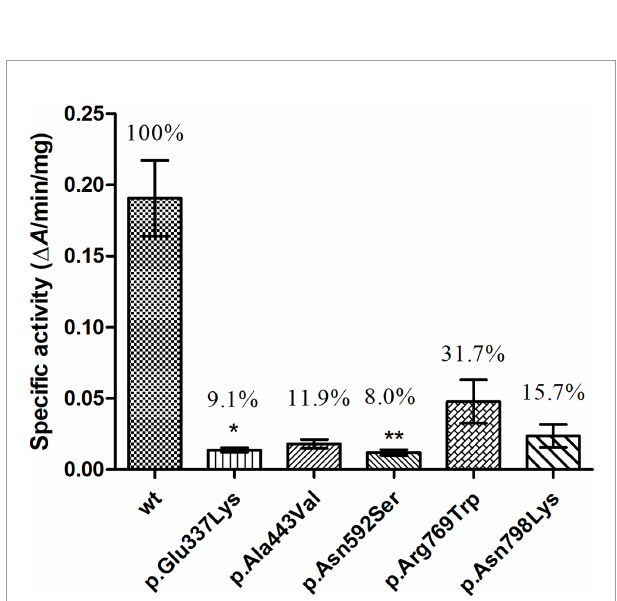
FIGURE 5 | Enzymatic activity of wild-type (wt) and mutant TPO proteins. *P < 0.05; **P < 0.01. P value refers to Dunnett ’ s test, all compared with wild-type TPO